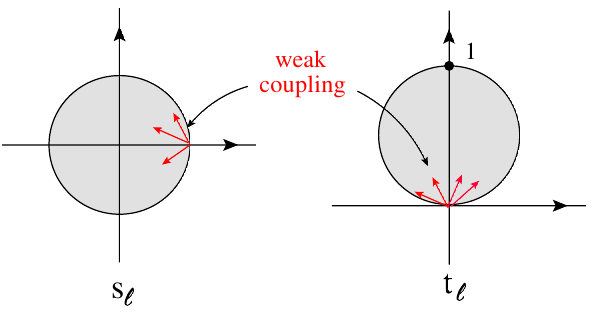
Figure 21 . The region allowed for s ‘ and t ‘ by unitarity. At weak coupling this constraint is only reflected in Re [ s ] ≤ 1 and Im [ t ] ≥ 0 ‘ ‘